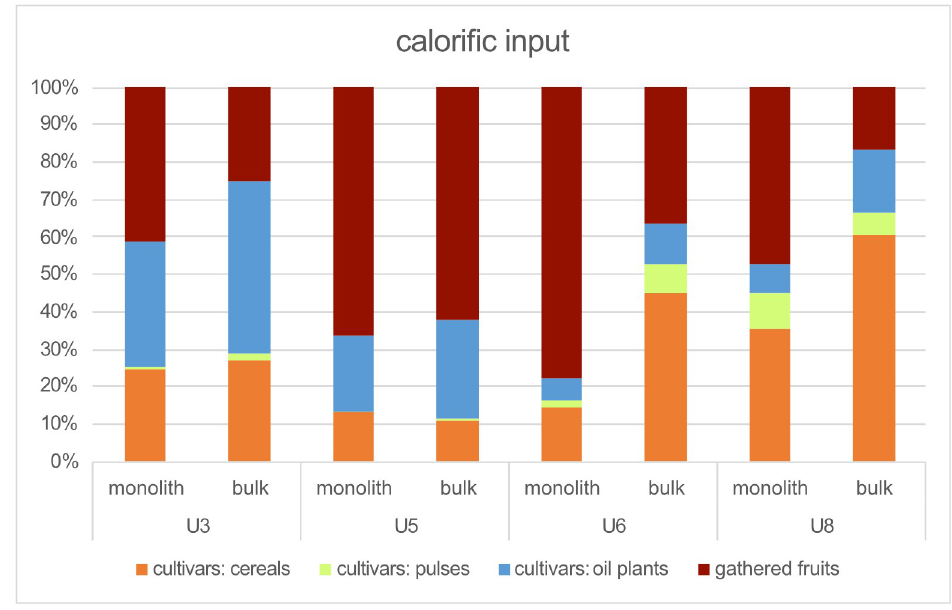
Fig 20. Comparison of the caloric input of cultivars and gathered fruit.